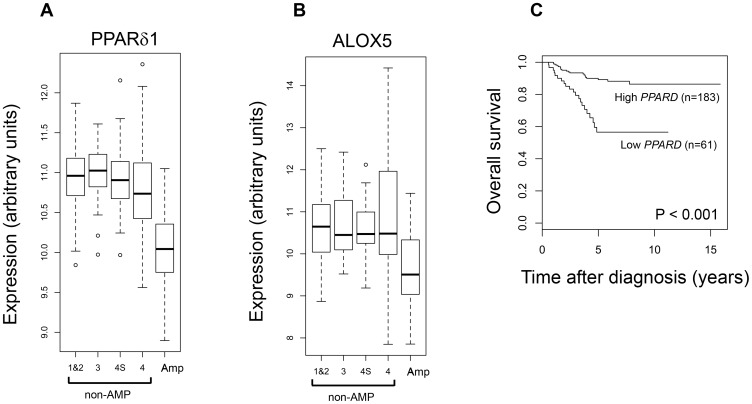
Clinical data from a cohort of 251 primary neuroblastomas.Expression of (A) PPARδ1 mRNA and (B) ALOX5 (5-LO) mRNA in stages 1–4, 4S and MYCN amplified (Amp) groups. (C) Kaplan-Meier survival analysis for 251 primary neuroblastomas based on PPARδ1 mRNA expression. Low PPARδ1 or ALOX5 expression was significantly associated with MYCN amplification status (Wilcoxon test; P<0.001 for both). For Kaplan-Meier analysis of patient survival, a cut-off at the first quartile was used to distinguish between low PPARδ1 and high PPARδ1 expression: low PPARδ1 expression defined in this way was significantly associated with poor survival (Log Rank test, P<0.001). Multivariate analysis with: age at diagnosis, MYCN amplification status, stage and PPARδ1 expression showed that PPARδ1 expression did not contribute significantly (P = 0.866). Box and whisker plots show the median (horizontal line), 25th and 75th percentiles (box horizontal boundaries), with the whiskers above and below extending to the most extreme data point>1.5 times the interquartile range from the box. Outliers are shown as circles.